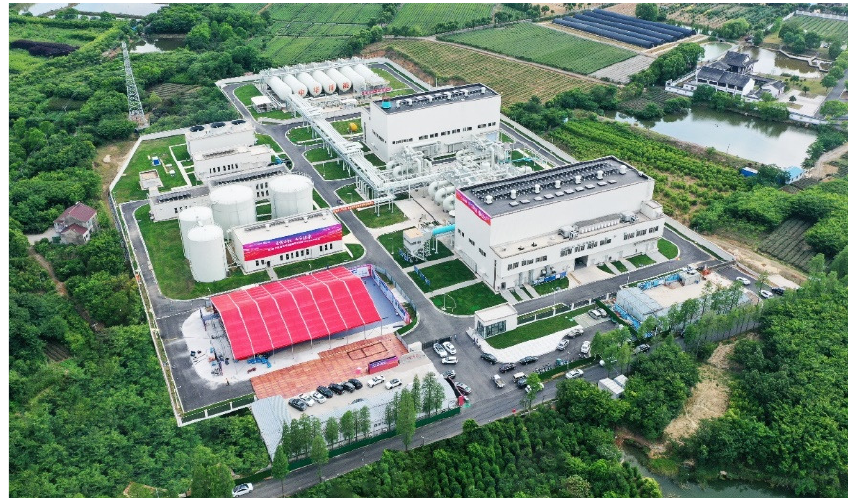
Fig. 1 Aerial panorama of Jintan Salt-cavern Compressed Air Energy Storage National Demonstration